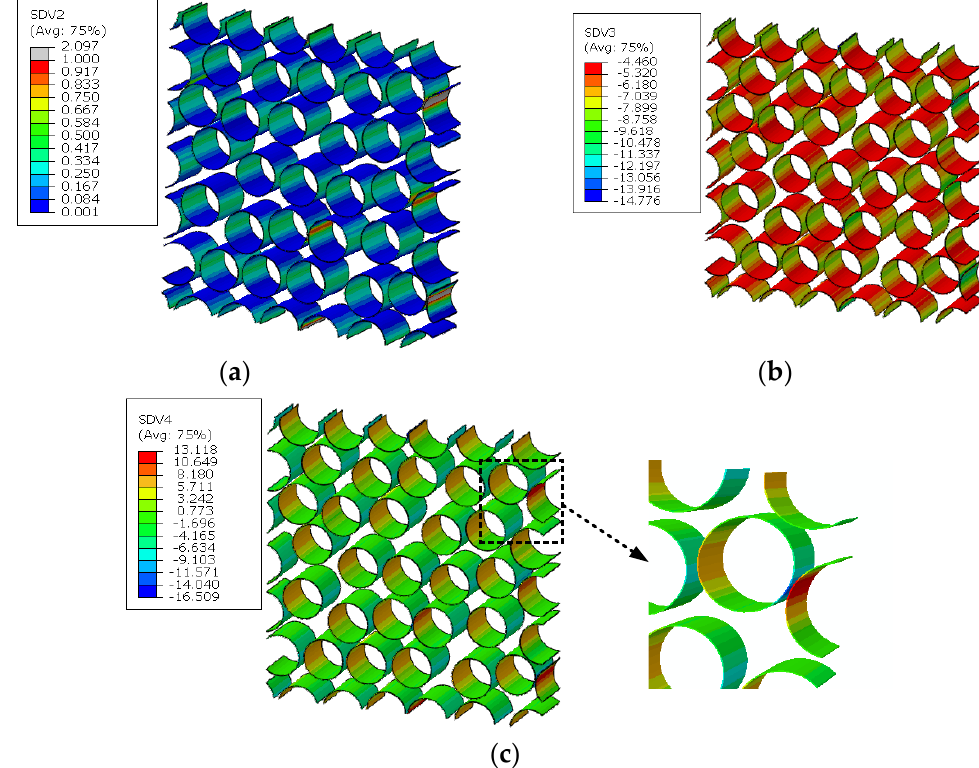
Figure 31. Failure indices and traction force states for the interface. ( a ) failure indices; ( b ) normal traction; ( c ) longitudinal shear traction.